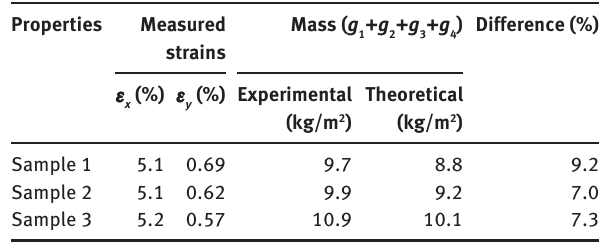
Figure 12 Use of strain gauges for measuring axial ε ential ε y